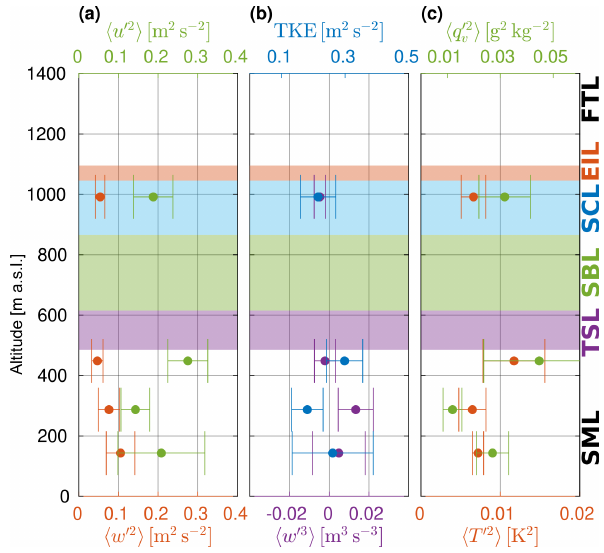
Figure 9. Statistics of turbulent fluctuations in the coupled STBL (flight no. 5): (a) variance of horizontal (cid:104) u (cid:48) 2 (cid:105) and vertical velocity (cid:104) w (cid:48) 2 (cid:105) , (b) turbulence kinetic energy TKE and third moment of ver- tical velocity (cid:104) w (cid:48) 3 (cid:105) , (c) variance of temperature (cid:104) T (cid:48) 2 (cid:105) and specific humidity (cid:104) q (cid:48) v 2 (cid:105) .